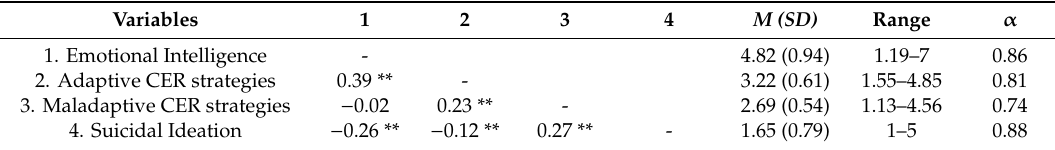
Table 1. Descriptive statistics of the Study